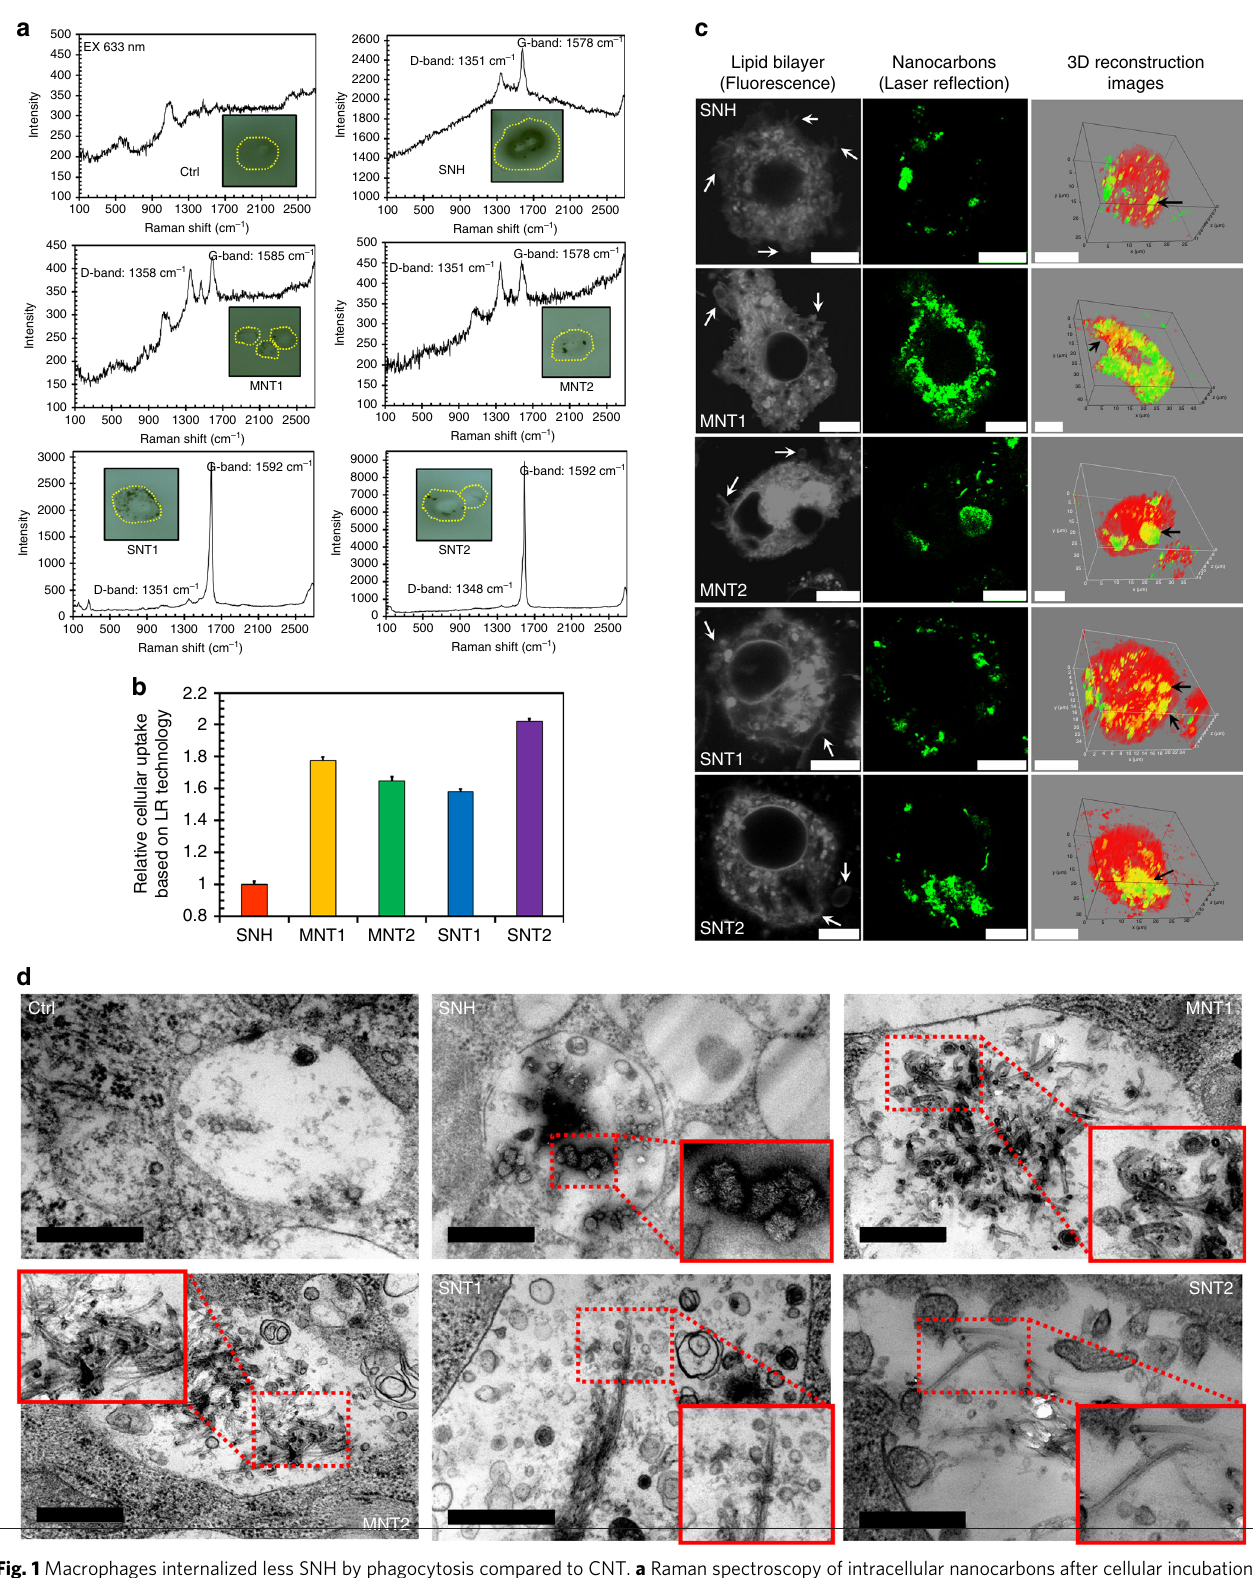
Fig. 1 Macrophages internalized less SNH by phagocytosis compared to CNT. a Raman spectroscopy of intracellular nanocarbons after cellular incubations. The insert graphs showed the corresponding cells detected by microscope. b Relative cellular uptake comparison of fi ve nanocarbons based on laser re fl ection (LR) signal detection ( n = 3). c Confocal images of cells after nanocarbon incubations. Intracellular nanocarbons were detected by CLSM via LR technology. Cell membrane and endomembrane were stained with lipid dye DiI. White arrows indicated the membrane wrinkles. 3D reconstruction by Imaris software illustrated the co-localizations of nanocarbons with DiI-labeled vesicles (yellow spots, black arrows). Scale bar: 10 μ m. d Transmission electron microscopy images of intracellular lysosomes after nanocarbon incubations. The magni fi ed insets showed the signi fi cant morphological features of nanocarbons. Scale bar: 500 nm. In b , three independent nanocarbon incubations were performed in study. Data were expressed as mean ±